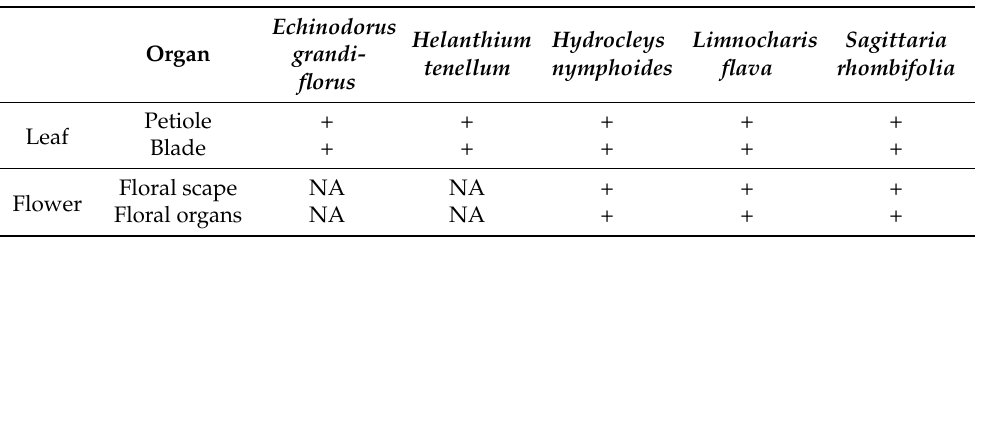
Table 1. Distribution of secretory ducts in the vegetative and floral organs of Echinodorus grandiflorus